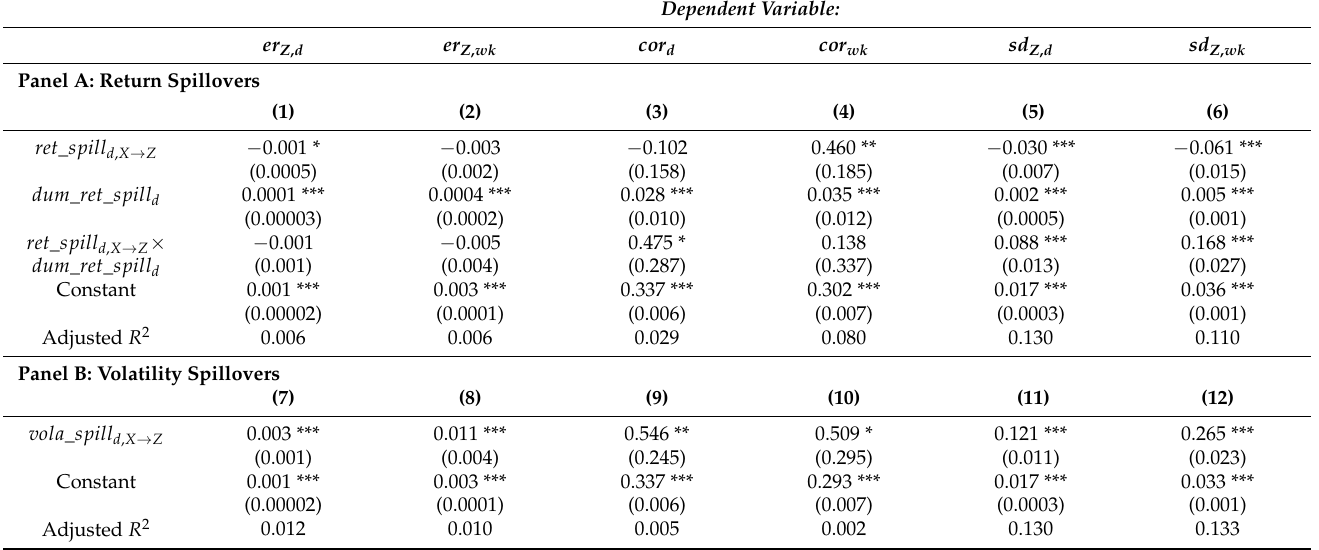
Table 5. Empirical analysis: Links between spillovers and assets’ characteristics. This table presents results of the regressions of various assets’ characteristics at daily and weekly frequencies on daily return spillovers (Panel A) and volatility spillovers (Panel B). Within each of 435 pairs of two stocks formed by 30 DJIA constituents, we estimate contemporaneous correlation between the two stocks, return and volatility spillovers from one stock to the other, as well as the expected returns and variances of the spillover-receiving stock. Within each pair, a stock plays either role, spillover giver or spillover receiver. We denote X as the spillover-giving stock and Z as the spillover-receiving stock. dum _ ret _ spill d is a dummy variably which equals 0 if return spillover is negative and 1 otherwise. Standard errors are in parentheses. *, **, and *** denotes significance levels of 1%, 5%, and 10%,